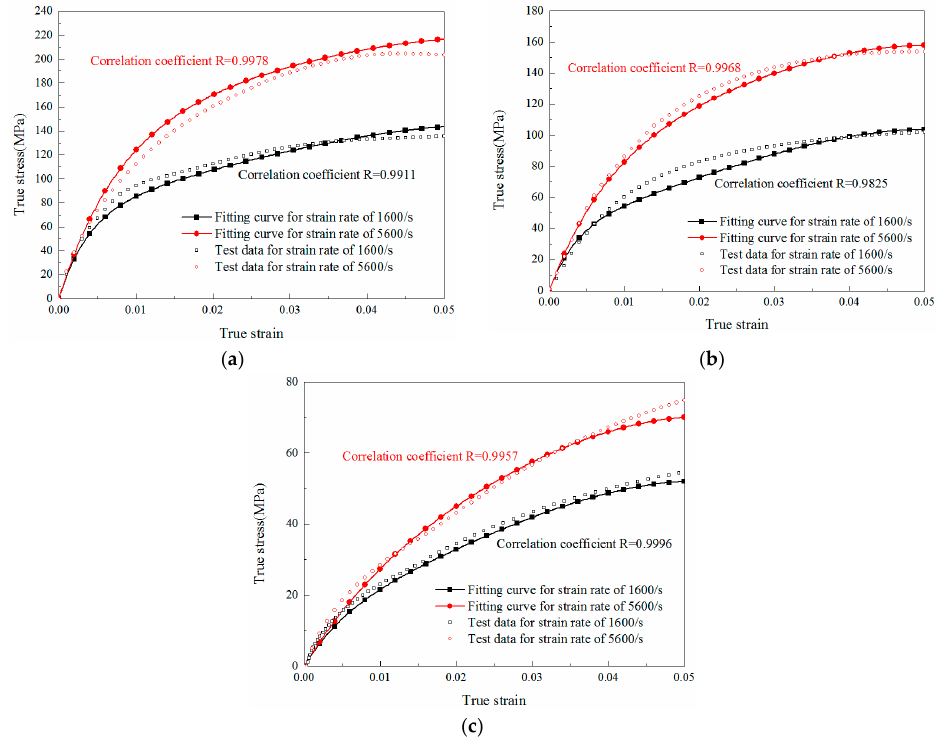
Figure 12. Comparison between predicted model results and experimental data at different strain rates for specimens with different LNBR content: ( a ) 0% (M0); ( b ) 10% (M1); ( c ) 25%